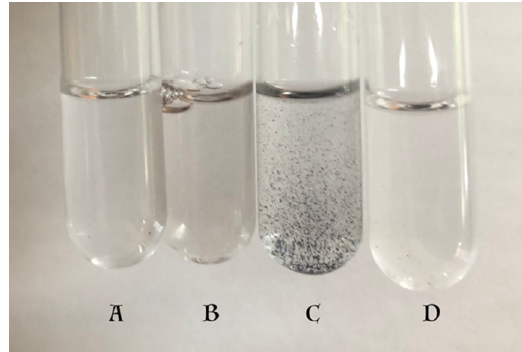
Figure 4. Stability of DHI stored in water at room temperature. ( A ) DHI solution at zero-time. ( B ) DHI solution after 2 h. ( C ) DHI after overnight incubation. ( D ) DHICA stored for 24 h. Note the discoloration of DHI in test tube ( B ). The solution of DHI left in air for 24 h, test tube ( C ), resulted in total precipitation of black-colored eumelanin pigment.